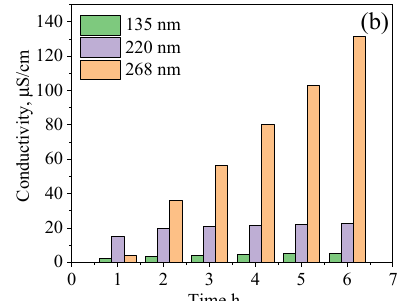
Table 4. Radioisotope composition of feed waste solution and permeate solution after DCMD process. Activity of the Radioisotope